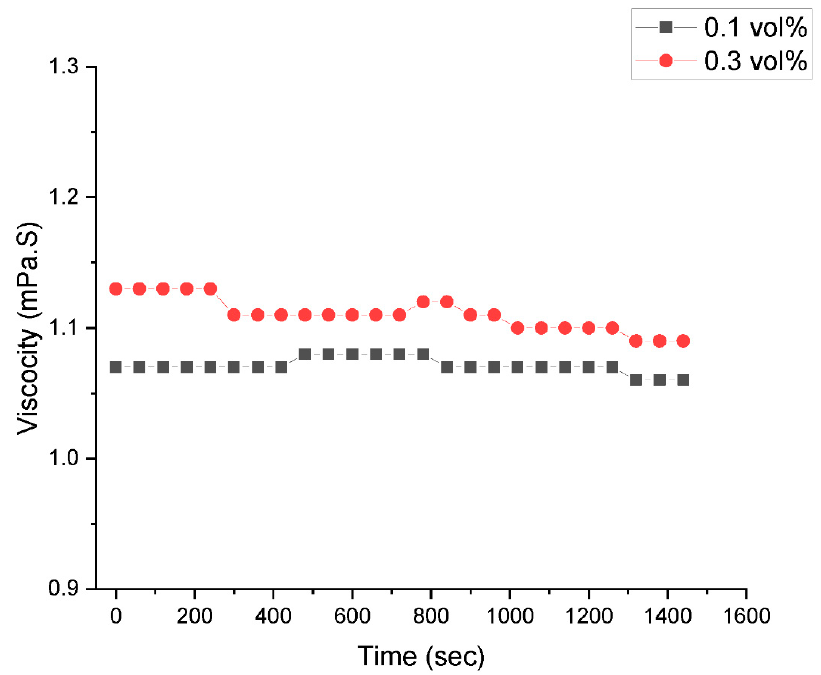
Figure 4. Viscosity-based stability measurement for 0.1 vol% and 0.3 vol% hybrid nanofluids.